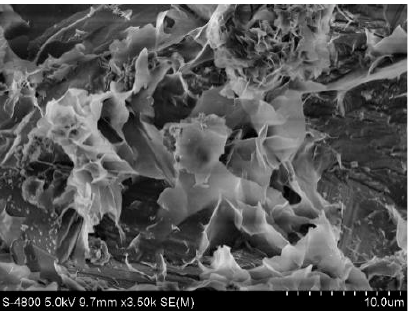
Figure 10. Garnet matrix before treatment.